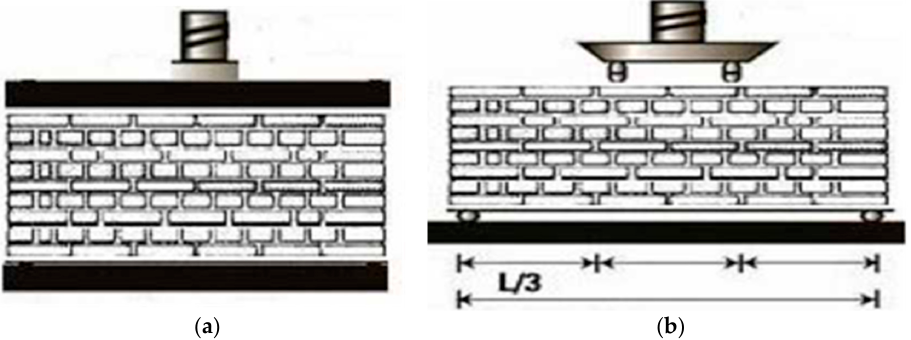
Figure 4. Test mechanism for brick masonry: ( a ) compressive strength; ( b ) flexural strength.